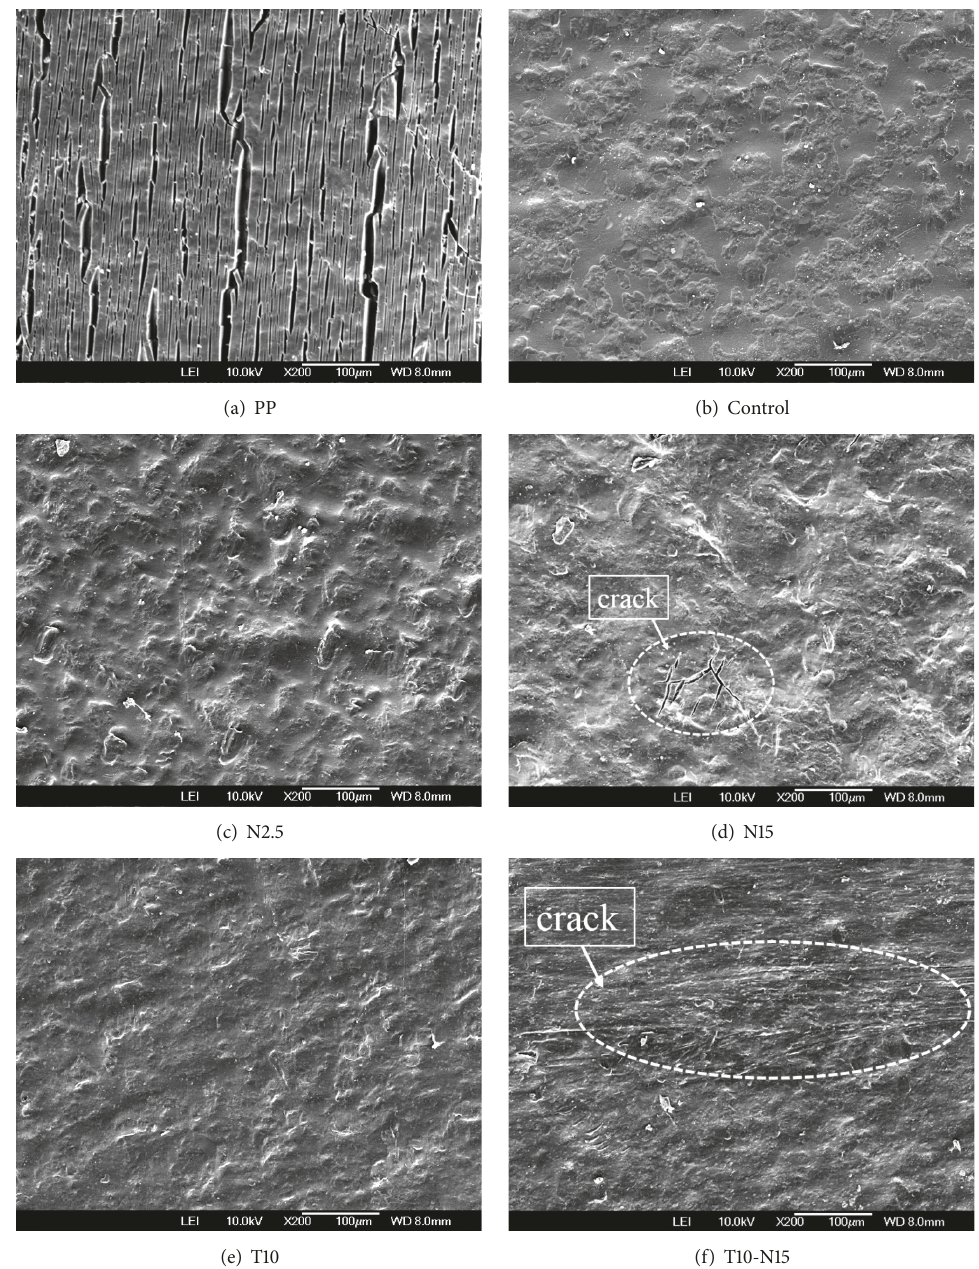
Figure 6: SEM images of pure PP, control, NCC-only, and NCC-talc hybrid filled PP-based composites after 1,000 hours of accelerated weathering